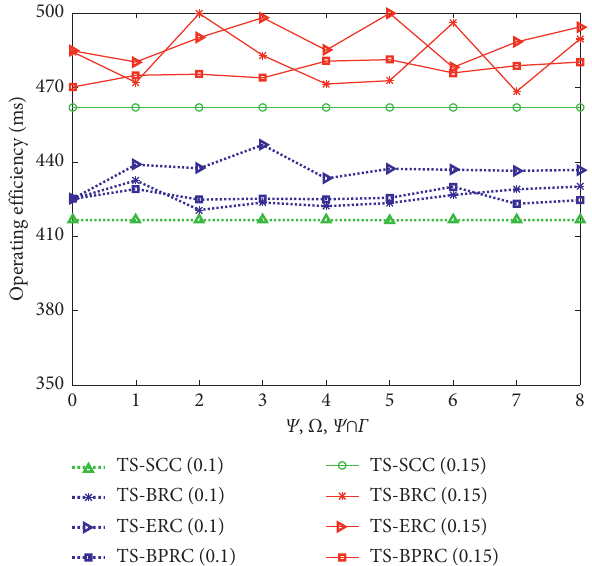
Figure 7: Model operation efficiency comparison.